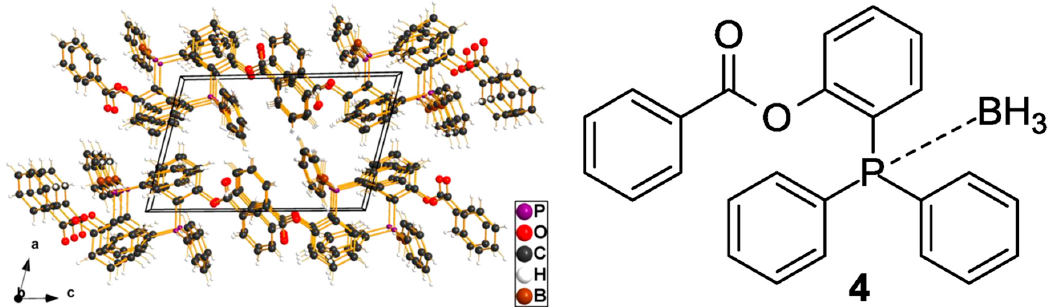
Figure 2. View of the packing of molecules in crystals of the phosphane borane adduct (denoted 4 ) along the crystallographic b axis, and view of its molecular structure. Adapted from reference [10]. Reproduced with permission from reference [10], published by MDPI,